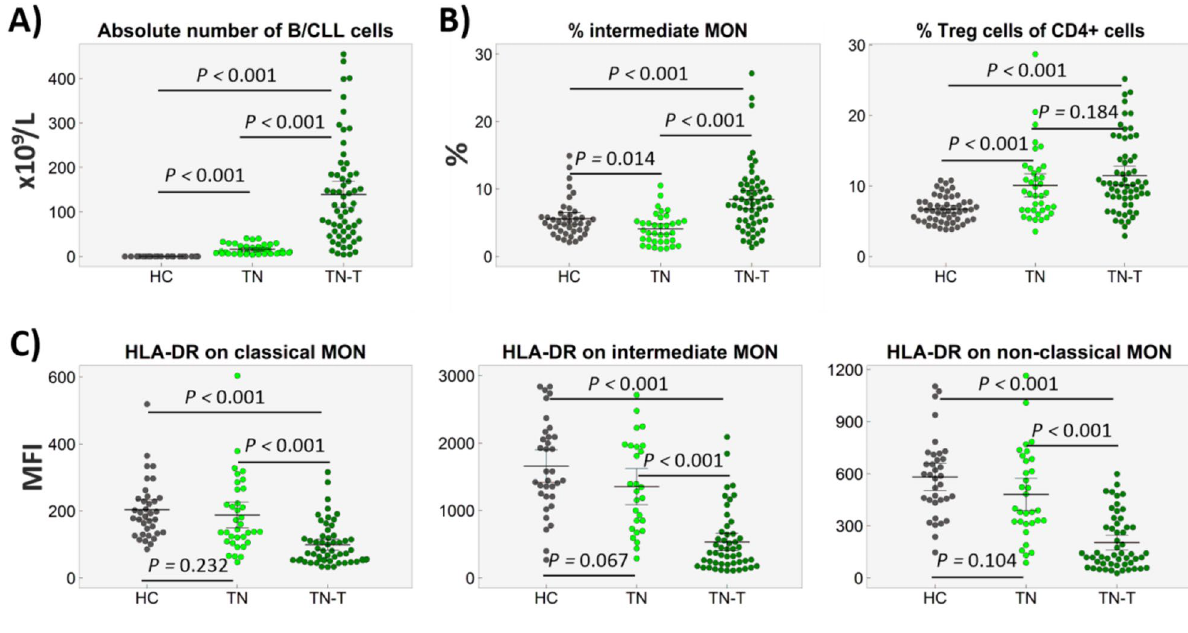
Figure 6. Distribution of circulating cells in treatment-naïve CLL patients who required treatment within one year (TN-T), treatment-naïve patients with the slow disease course (TN) and healthy controls (HC). ( A ) CLL cell counts in CLL patients or B cells in healthy controls. ( B ) Percentages of intermediate monocytes and proportion of Treg cells within CD4+ T cells. ( C ) Expression of HLA-DR on classical, intermediate and non-classical MON. In a minority of patients, the data are missing due to low abundance of monocyte cell